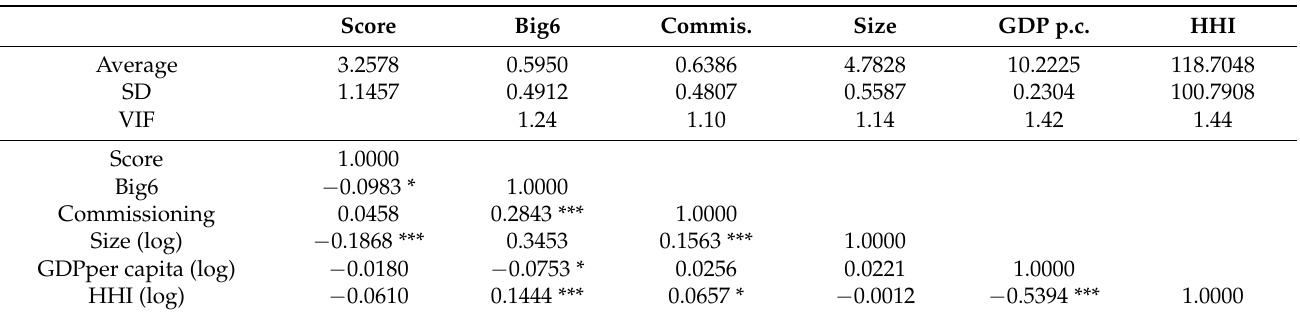
Table 3. Correlations and Variance Inflation Factor